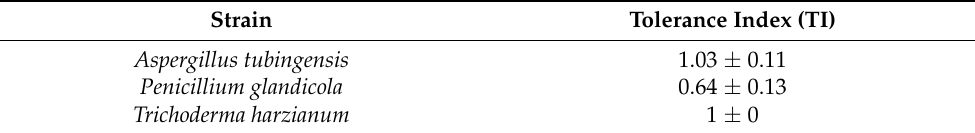
Table 5. Tolerance index.